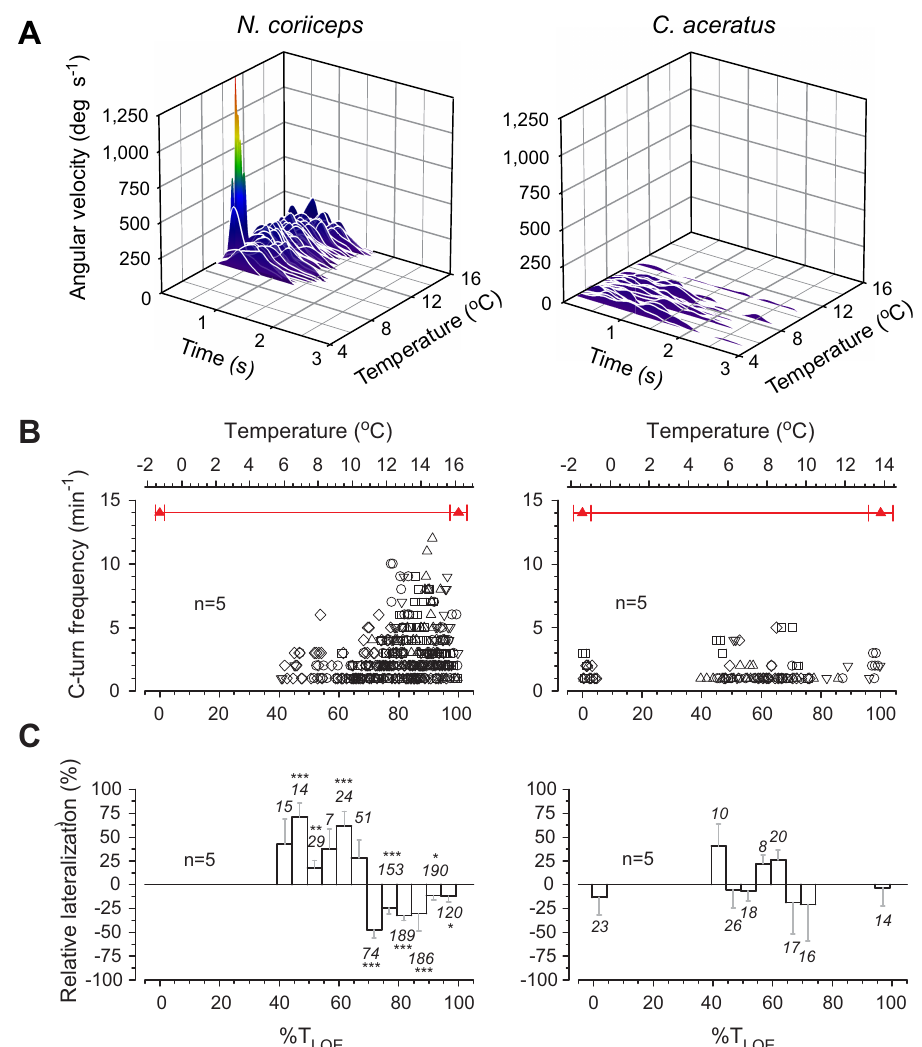
Fig 4. Startle-like behaviors of Hb+ N. coriiceps and Hb- C. aceratus as a function of temperature. (A) Time plots of angular velocity (V a ) during startle-like maneuvers at respective temperatures in a single specimen of N . coriiceps and C . aceratus . Rainbow color code denotes the continuum of angular velocities from low (violet) to high (red) during fast S-bend turns (V a > 500 deg � s -1 , 9 events) and intermediate velocity single-stage C-bend turns in N . coriiceps (V a < 250 deg � s -1 , 137 events), and during slow multi-stage C-bend turns (V a < 100 deg � s -1 , 25 events) in C . aceratus . (B) Data points represent number of C-bend turns during each consecutive time interval one minute in duration in five specimens (depicted as different symbols) of each species. (C) Relative lateralization (mean and SEM) of C-bend turns in 5% of T LOE increments averaged between five specimens of each species. For conventions of quantification and presentation of grouped data as a function of temperature, see Materials and Methods. Numerals next to bars indicate numbers of events within each temperature increment in five animals. Asterisks denote statistical significance of laterality bias ( p values between 0.024 and 0.032 - � ; p = 0.0012 - �� ; p < 0.001 - ��� ) at each temperature interval compared to a random choice (0% laterality) using one sample t -tests. from 0.88 to 0.96) than in N . coriiceps ( r ranging from 0.40 to 0.71). Namely, after reaching the maximum, C . aceratus continue to hyperventilate until the 1–1.5˚C prior to LOE, whereas f of N . coriiceps declines precipitously within a rather narrow interval of temperature rise (~2˚C) to a plateau at a lower, yet still relatively elevated, level. Two other measures of opercular movements are the opening amplitude (OA) and the opening time (OT). With rising temperatures, OA increases progressively in both species,